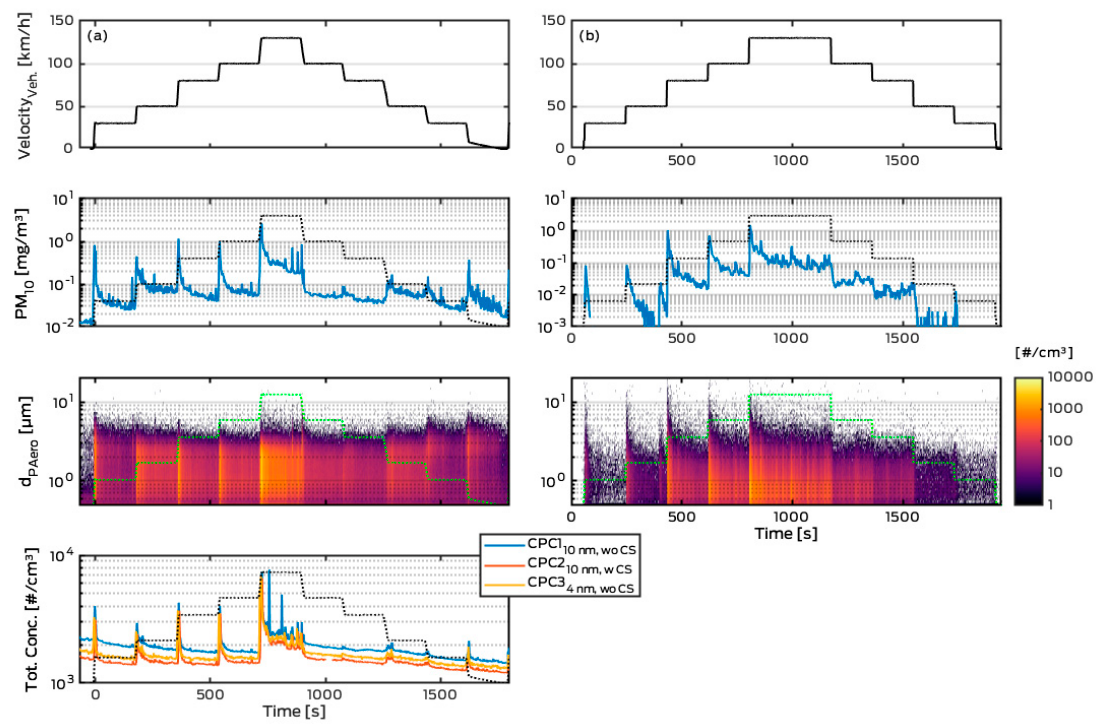
Figure 7. Timeline of pyramid-cycle without any brake application. Left side ( a ) refers to chassis dyno measurements. Right side ( b ) refers to brake dyno testing. Top to bottom: Velocity profile (black, left axis); PM 10 concentration (TSI DustTrak); PN size distribution (dN / d log dP) (TSI APS); and PN concentration (CPCs with (CPC34nm, CPC210nm) and without (CPC110nm) CS. In all cases dotted lined indicate speed trace as reference.